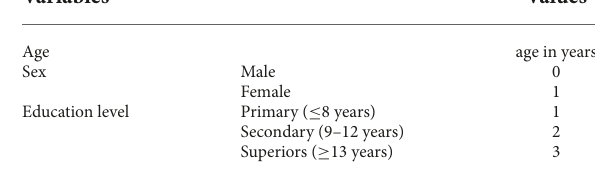
TABLE 5 Variables included in the equations and values to be used in the regression-based norms formulae.